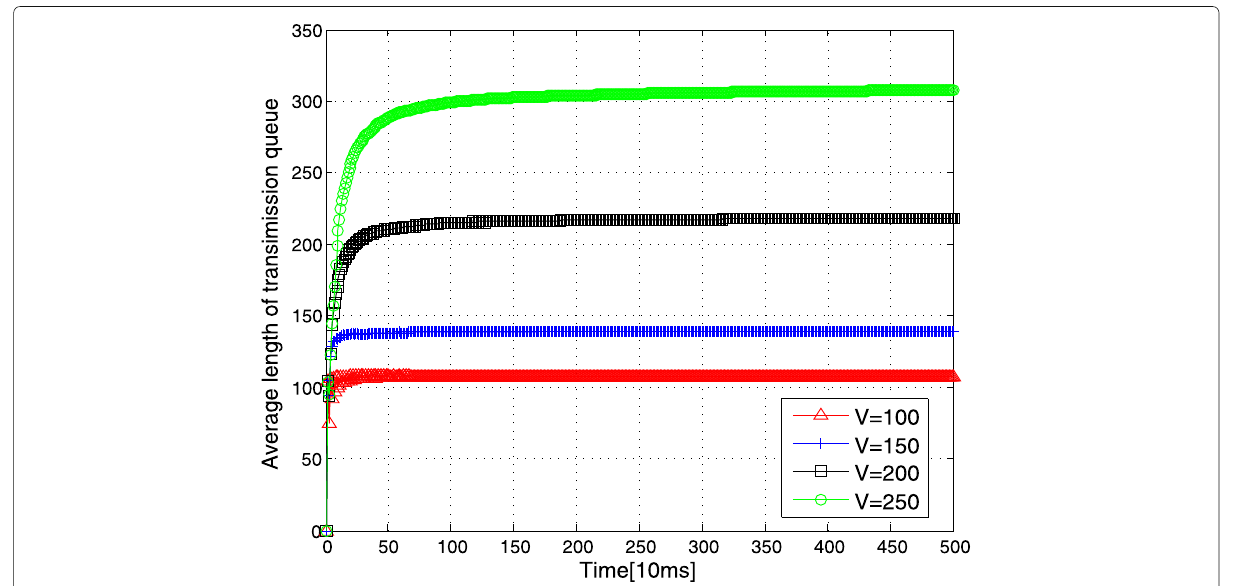
Fig. 11 The average length of the transmission queue versus time with different V